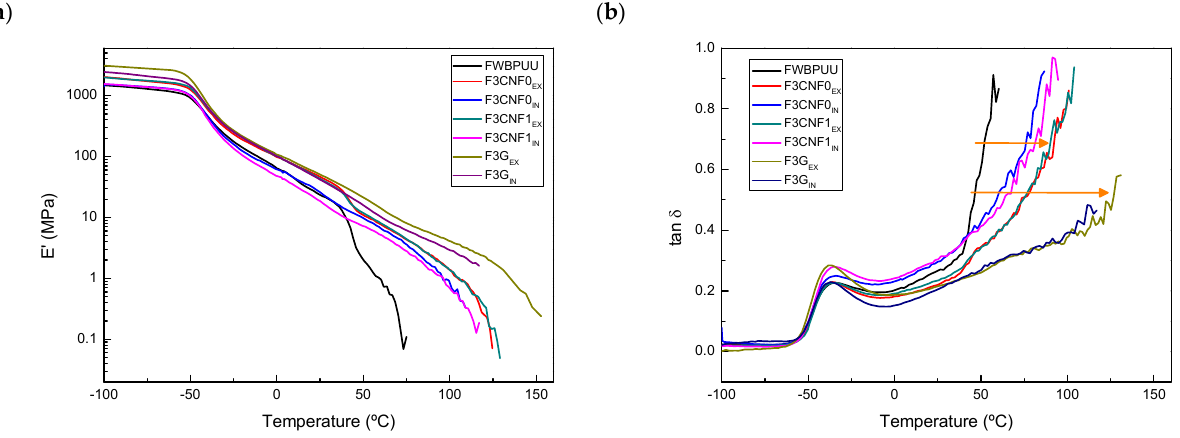
Figure 8. ( a ) Storage modulus and ( b ) tan δ curves of matrix and composite filaments.